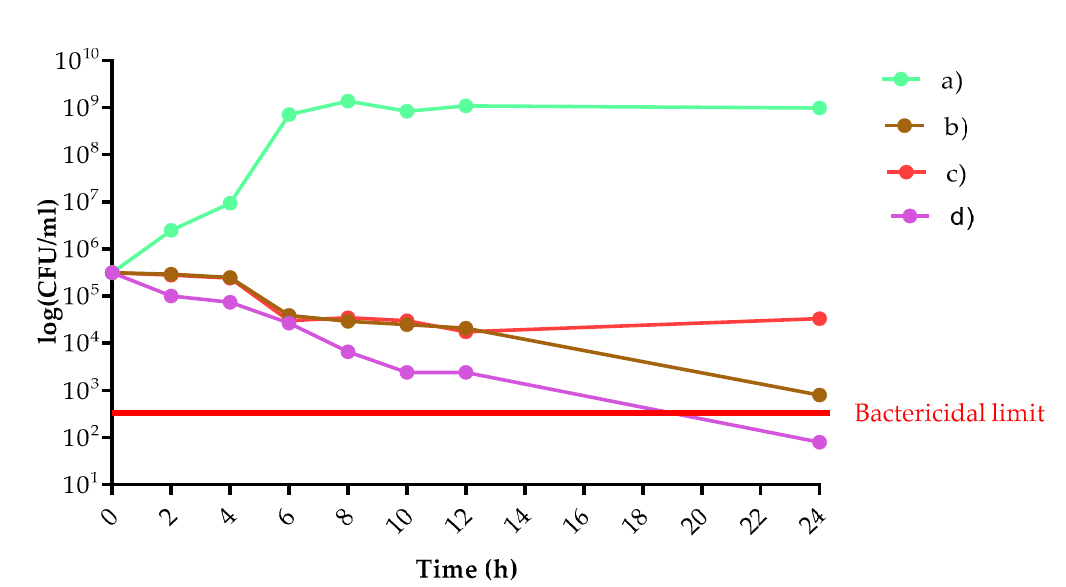
Figure 12. The logarithmical colony ‐ forming unit (CFU)/mL in case of E. coli versus time (h) where ( a ) empty vaginal ring; ( b ) metronidazole containing vaginal ring; ( c ) 3 w/w % chitosan and 4 w/w % hydroxyethyl cellulose ‐ containing vaginal ring; ( d ) 3 w/w % chitosan and metronidazole containing vaginal ring.